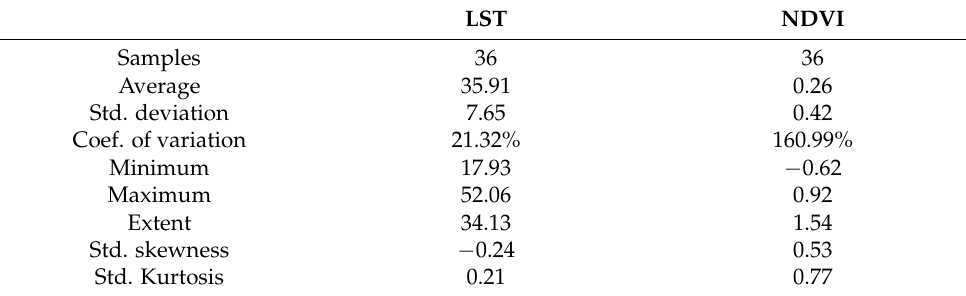
Table 5. Summary statistics of LST and NDVI.